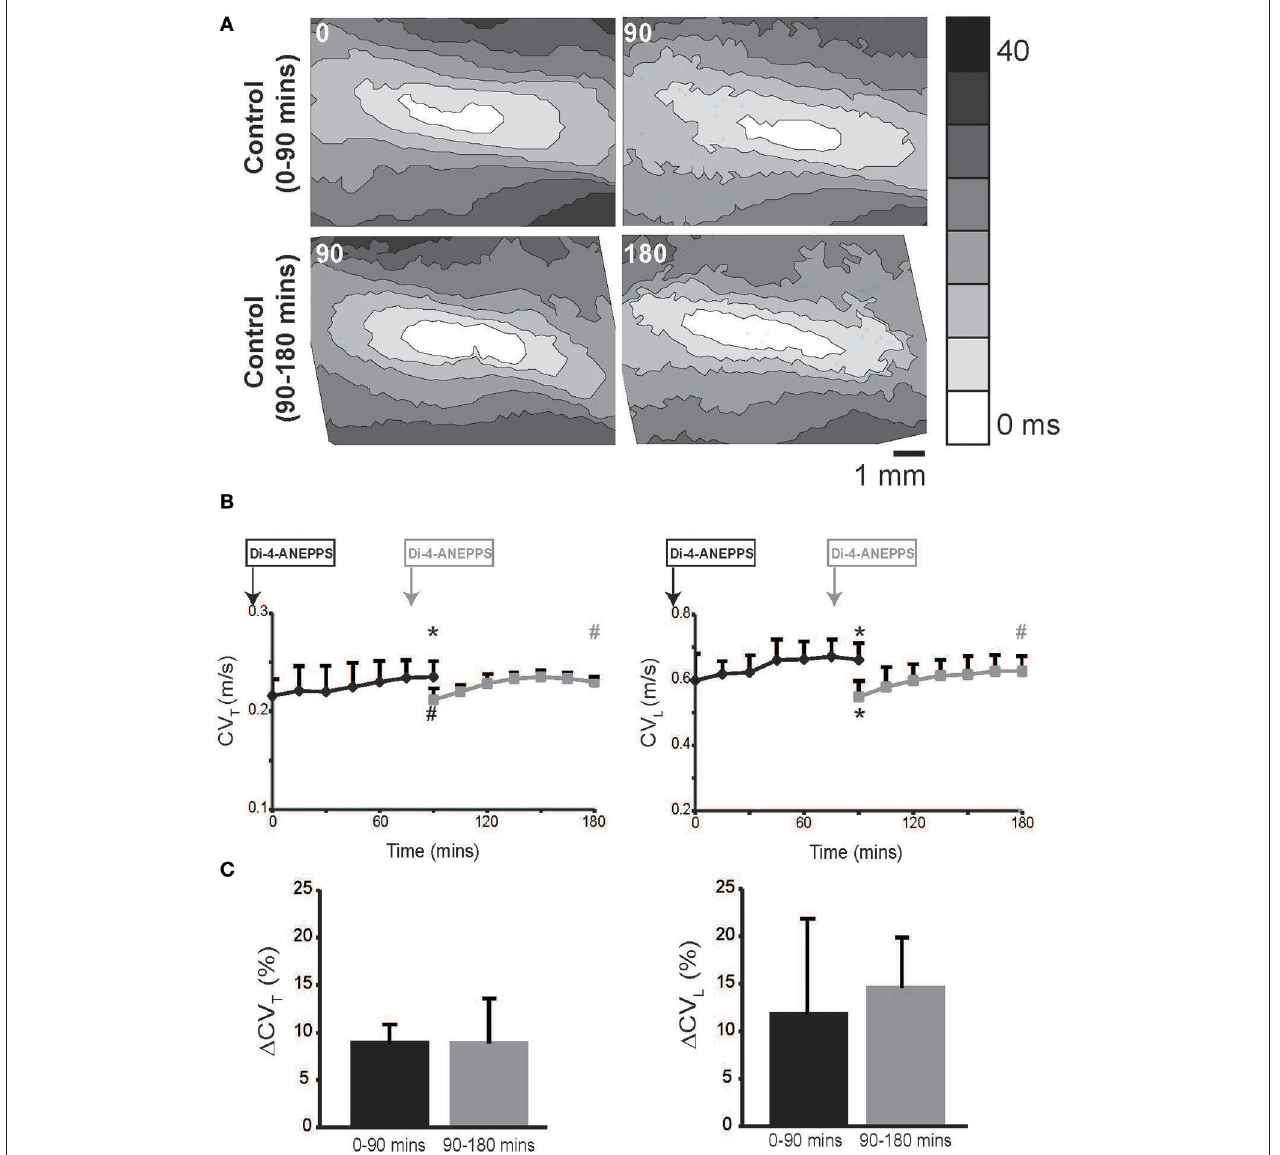
FIGURE 1 | Conduction velocity quantified by optical mapping increases with time. (A) Representative isochrone maps from control Tyrode’s solution perfused hearts at 0, 90 and 90, 180 mins. (B) Summary CV L and CV T measured up to 180 mins. Black curves indicate experiments where dye was perfused before t = 0mins and gray curves indicates experiments where dye was perfused at 75mins. (C) Percent increase in CV T and CV L over 90min durations in the two sets of experiments. Black and gray *Indicates p < 0.05 relative to t = 0 or 90mins respectively by paired comparison. Black # indicates p < 0.1 comparing between black and gray data point at 90 mins. Gray # indicates p < 0.1 comparing gray data point 90 and 180